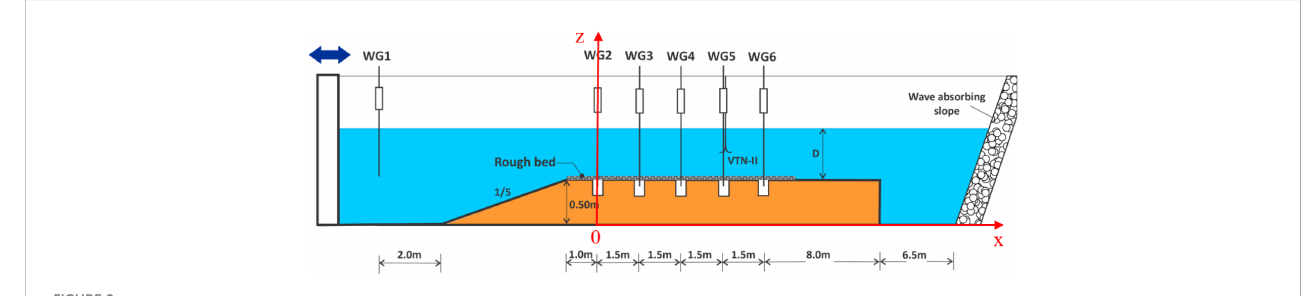
FIGURE 2 Side view of the tested model in the wave fl ume. Unit in m.